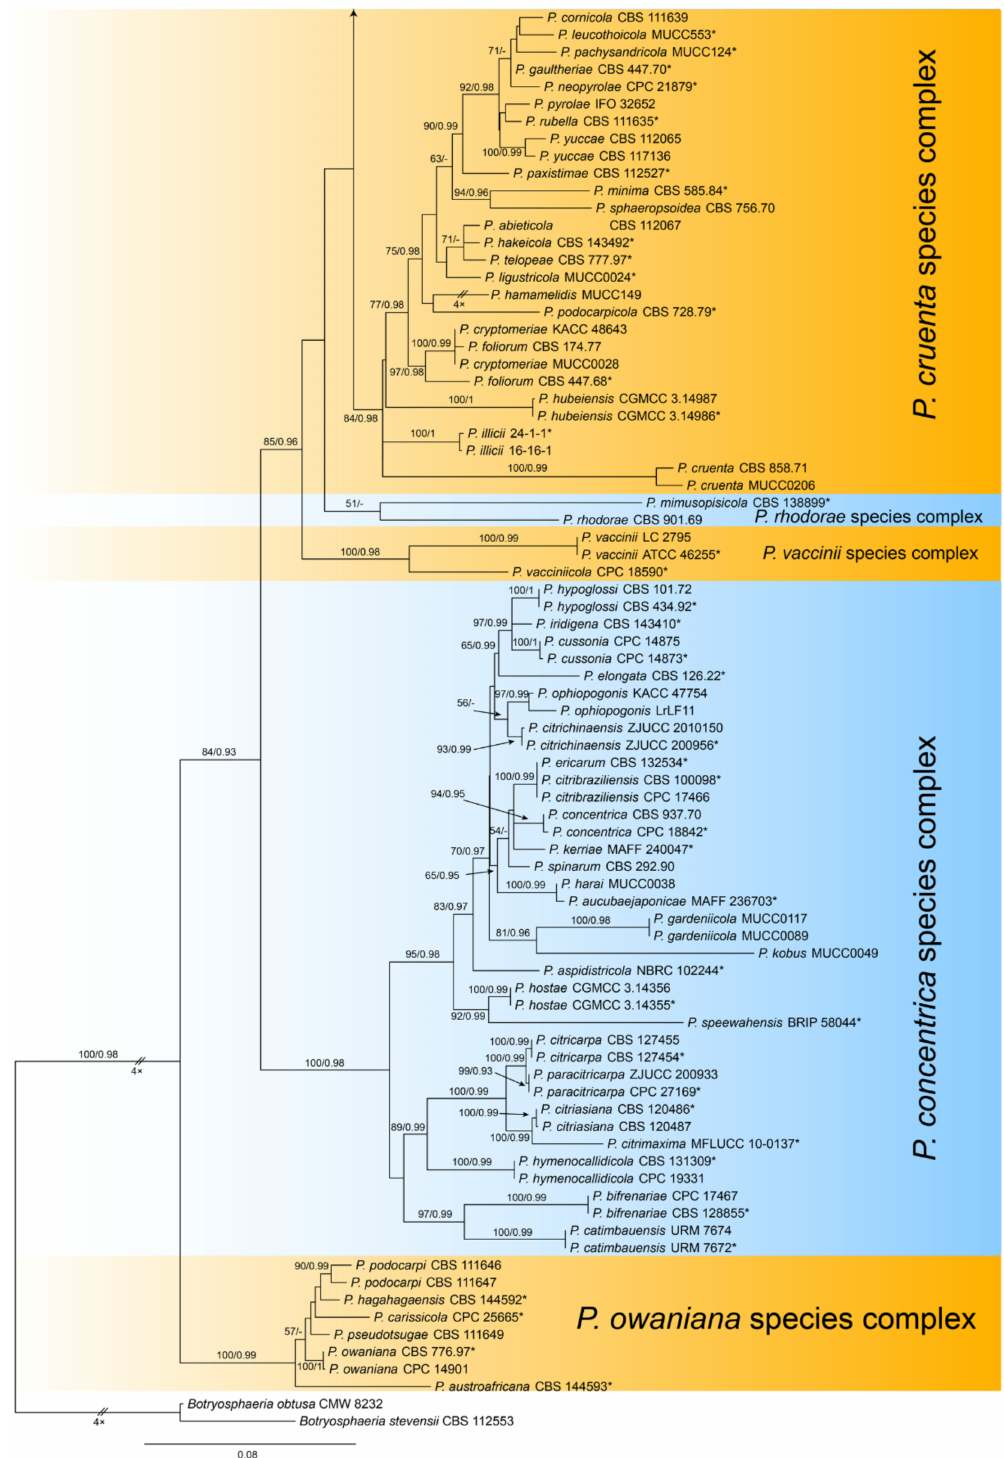
Figure A3. Phylogram generated from RAxML analysis based on combined ITS, LSU, act , gapdh and tef1 sequence data of Phyllosticta isolates. The tree was rooted to Botryosphaeria obtusa (CMW 8232) and B. stevensii (CBS 112553). The scale bar indicates 0.08 nucleotide changes per site. Isolates from this study are highlighted, and ex-type strains are marked with